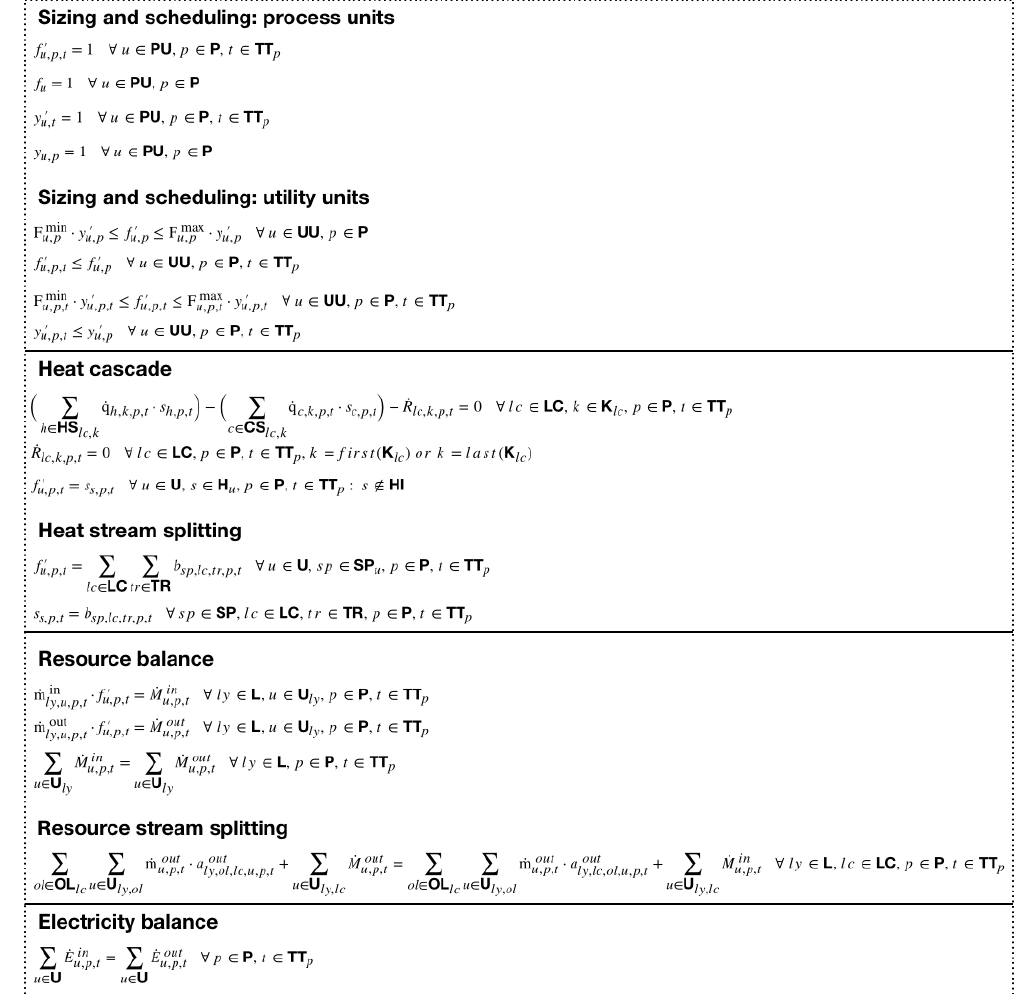
Figure 2. Formulation of the PI problem in